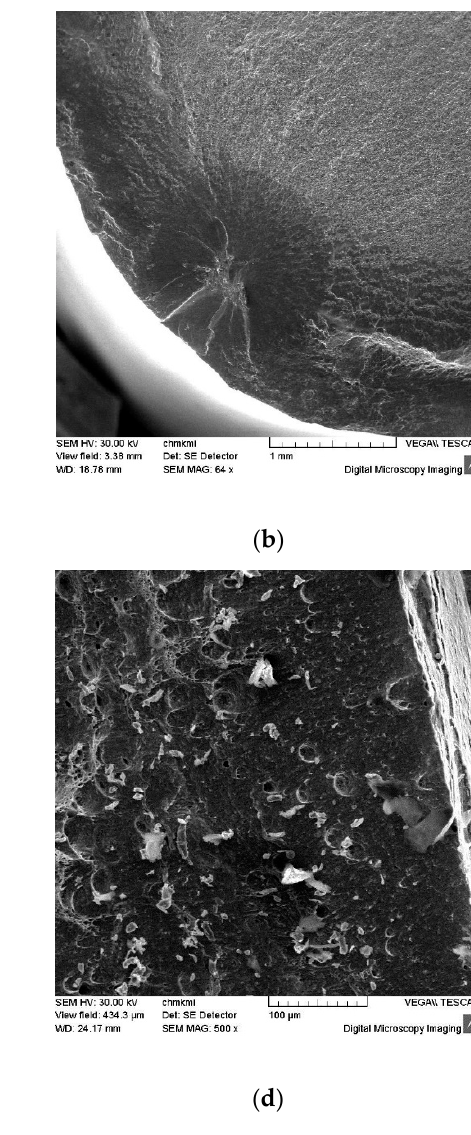
( d ) Figure 13. Fracture surface of UIP 85N Strenx 700 MC specimen loaded at 415 MPa and fractured after 5.8 × 10 6 cycles: Overall view of the fracture ( a ), detail of fish-eye fatigue crack initiation ( b ),